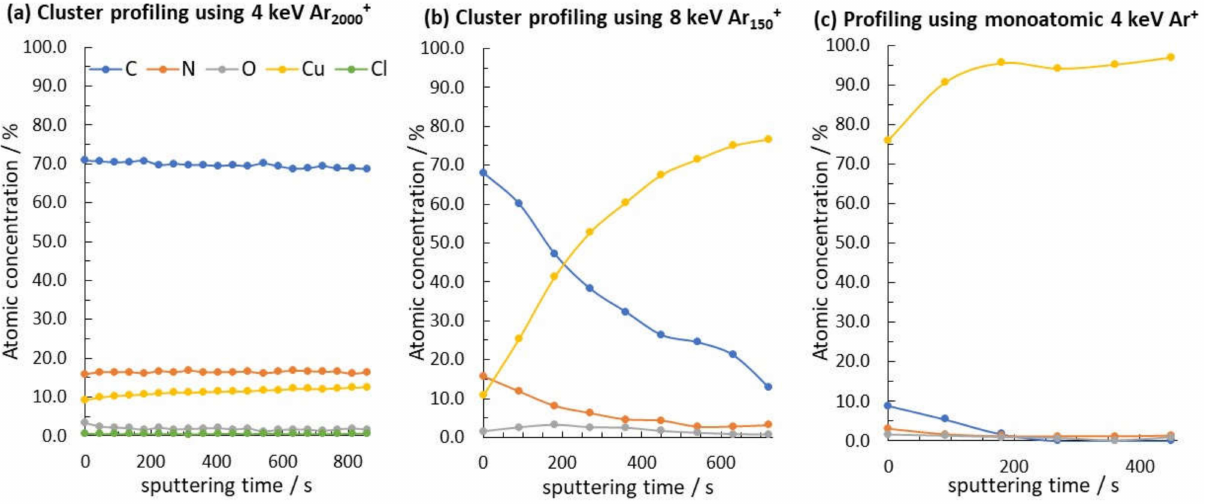
Figure 3. The change in atomic concentration (normalized to 100.0%) with an increase in sputtering time using: ( a ) 4 keV Ar 2000 + , ( b ) 8 keV Ar 150 + , and ( c ) 4 keV Ar + sputter